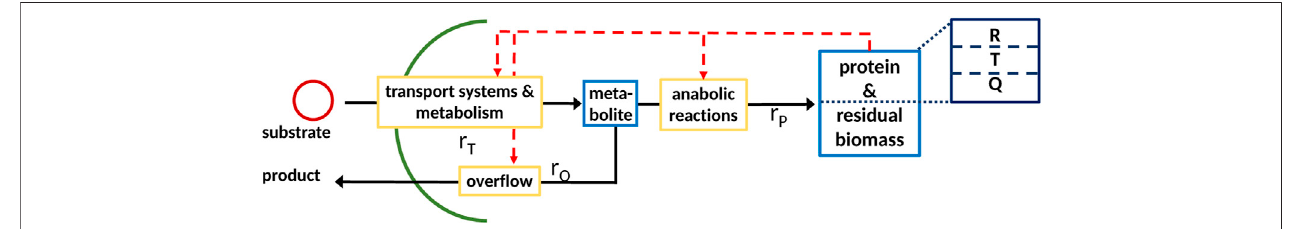
FIGURE1| Generalschemeofacoarse-grainedmodelwithpartitionedproteome(ribosomalproteins R ,proteinslinkedwiththecentralmetabolism T ,andresidual protein fraction Q ) as the self-replicator system Scott et al. (2014); it consists of two components, indicated as blue boxes; (metabolite, low molecular weight), protein; and residualbiomass(highmolecular weight;proteinisassumedtobe50%oftotalbiomass). Thepoolsareconnectedbyaminimalsetofreactions,indicatedbyyellow boxes, for substrate uptake, over fl ow metabolism, and protein